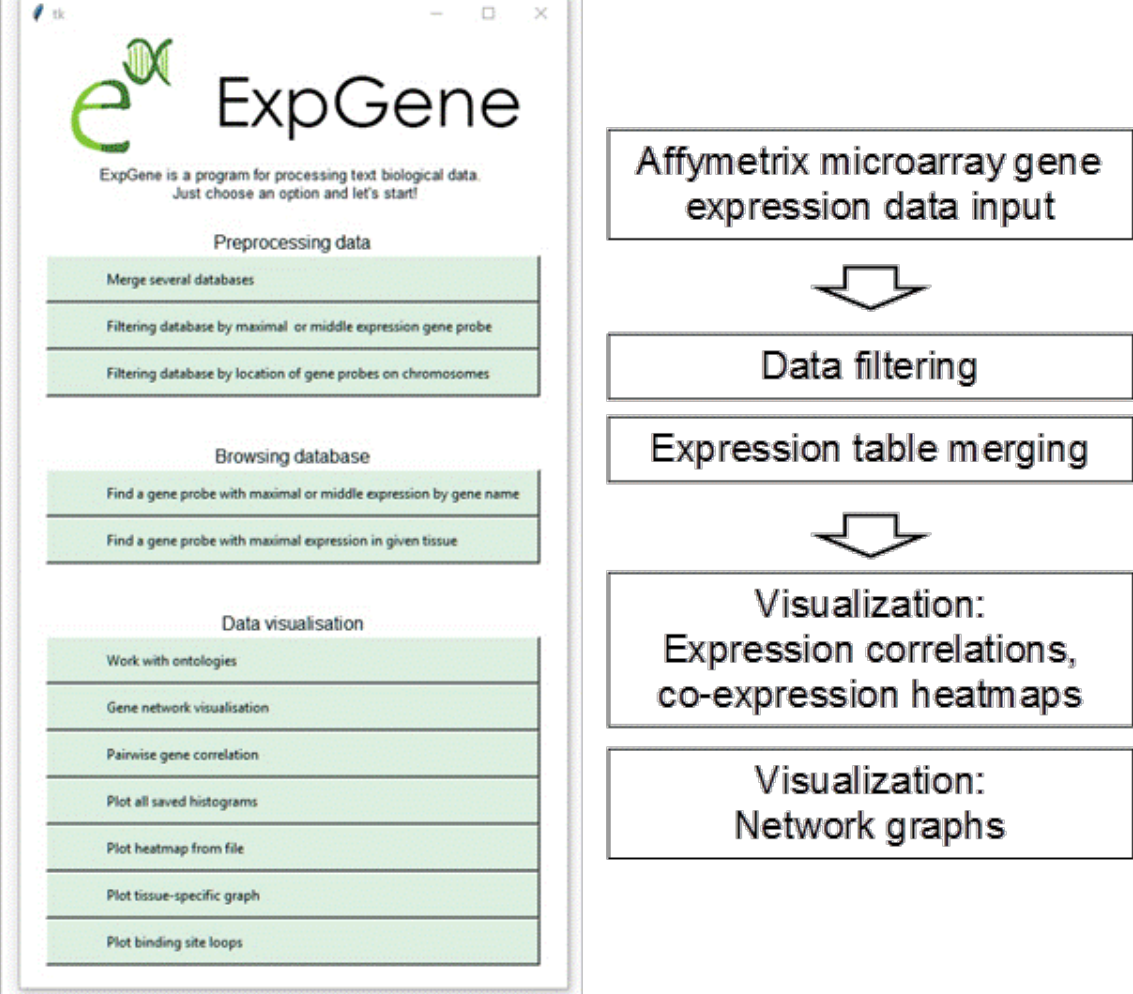
Figure 2: Interface of ExpGene program for gene expression and data workflow analysis (left panel) and microarray data processing for network